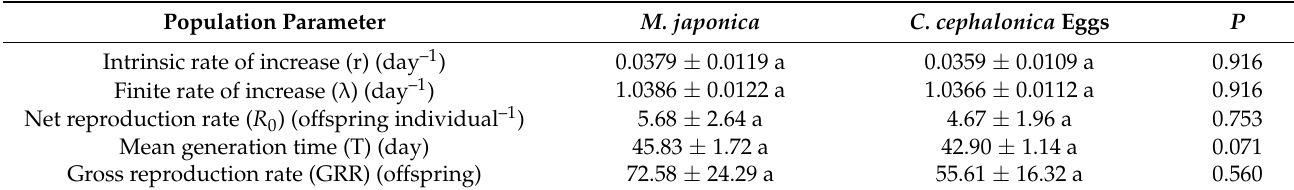
Table 2. Population parameters of Chrysopa pallens ever cultured on Megoura japonica and Corcyra cephalonica eggs fed on Aphis craccivora under fluctuating temperature conditions in a greenhouse (paired bootstrap test, B = 100,000, the same lowercase letters in the same column indicate the values are not significantly different, P > 0.05).